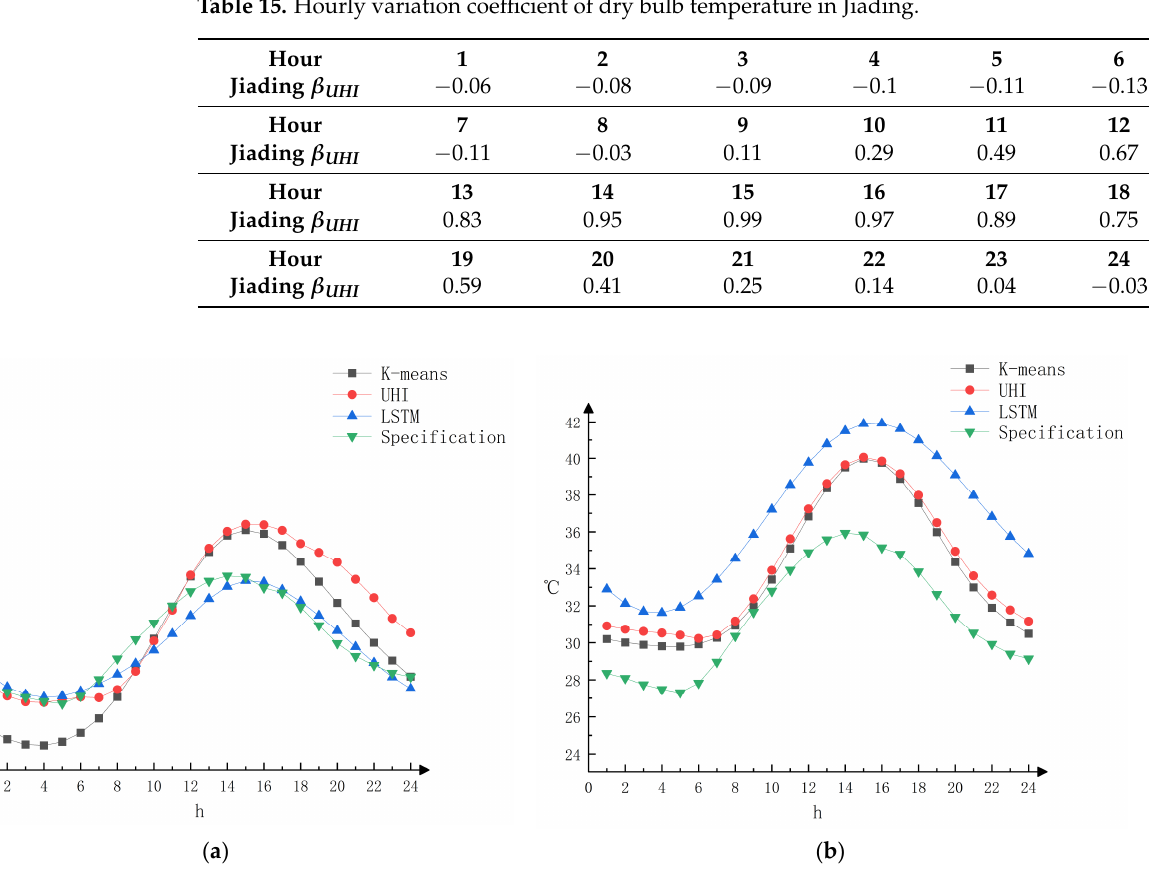
Figure 12. Design day comparison in Beijing ( a ) and Shanghai ( b ).